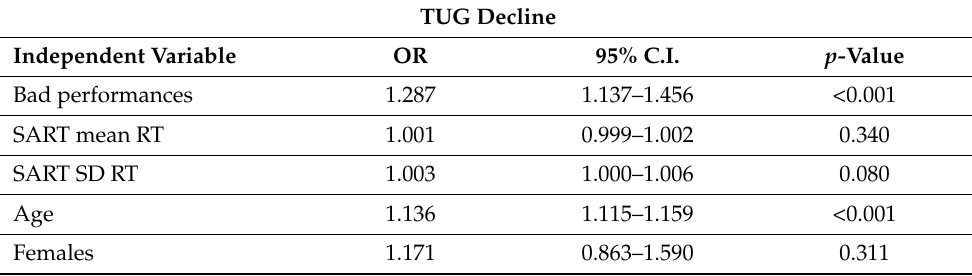
Table A1. Results for the fully adjusted per covariates binary logistic regression model 4 considering bad performances as potential predictor and having TUG decline as